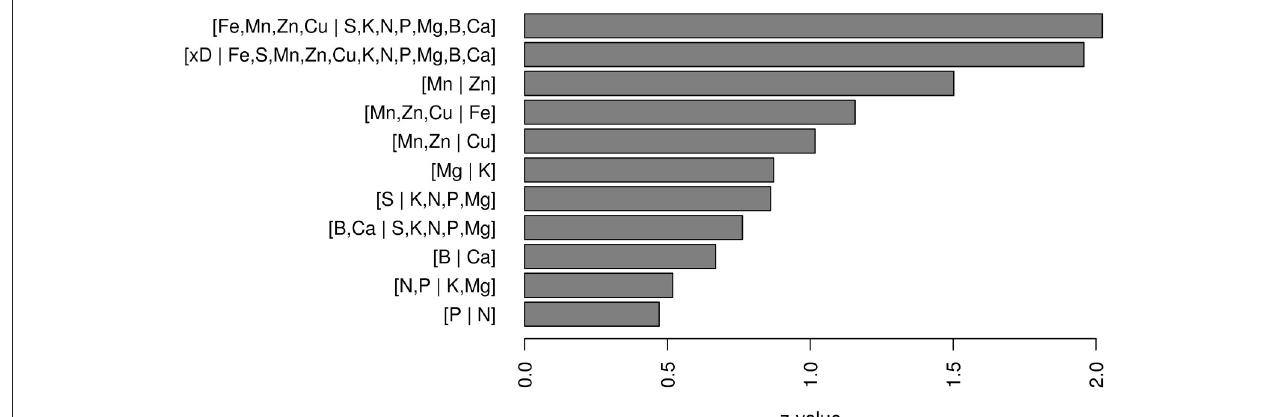
FIGURE 2 | Relative importance of z -values of balances in the logit model.